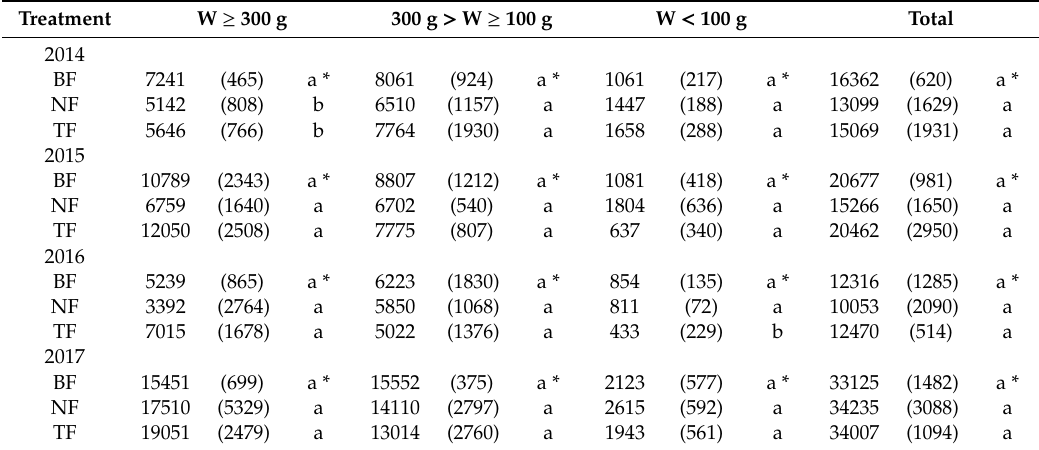
W: Weight per tuber. Values of standard deviations were in the parentheses. * Values in a column with di ff erent letters were statistically di ff erent by Duncan’s multiple range test ( p < 0.05). Values in a column with the same letter were statistically similar by Duncan’s multiple range test ( p >